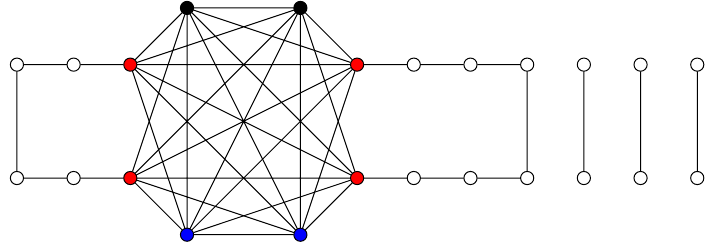
Figure 3. The strong resolving graph B SR of the graph illustrated in Figure